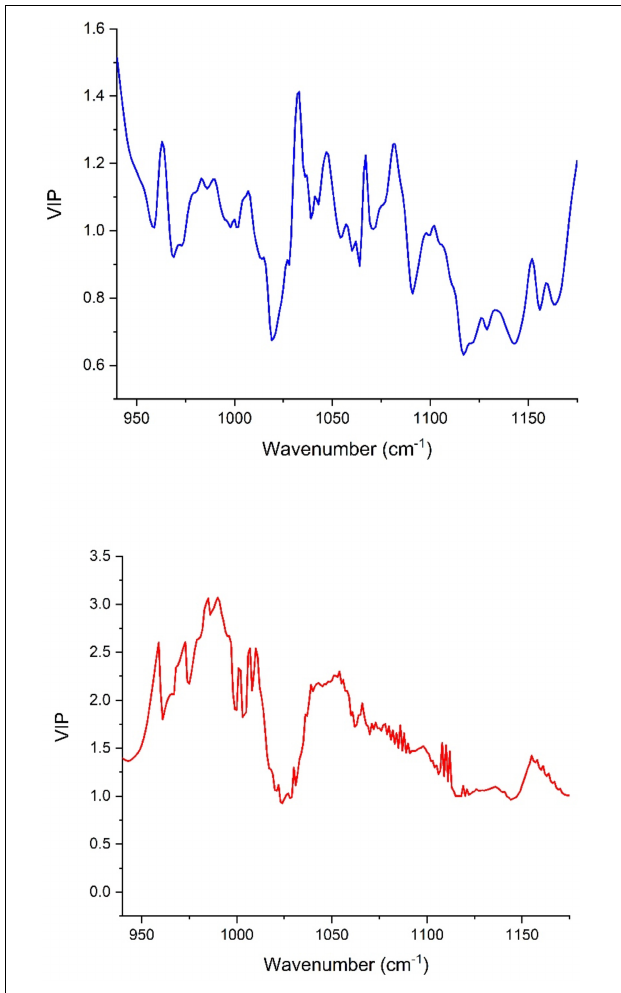
FIGURE 4 | Variables importance in projection (VIP) plot showing the contribution of each wavenumber in the PLSR model total variance for both peel (blue) and pulp